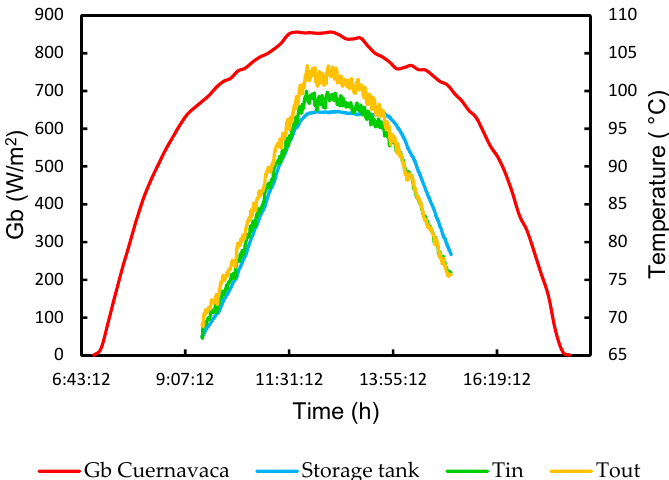
Figure 4. Behavior G b and outlet, inlet, and storage tank temperatures, 24 November 2017.